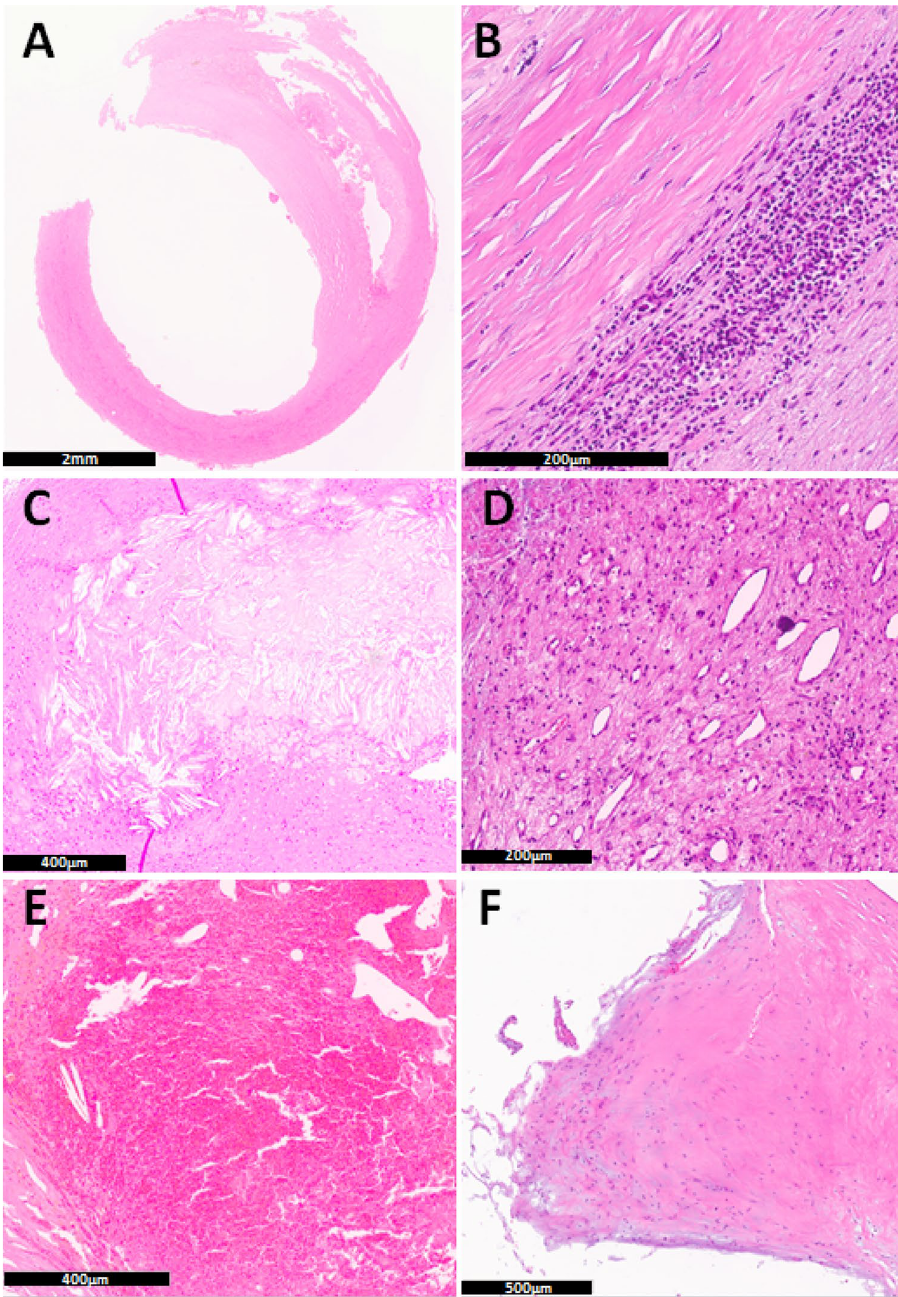
Figure 1. Histological criteria of plaque vulnerability. Representative sections displaying criteria of the histological sum score. Carotid plaque, HE-staining (overview, scale bar: 2 mm) ( A ). Representative areas of different specimens showing chronic inflammation (scale bar: 200 µm) ( B ), cholesterol crystals (scale bar: 400 µm) ( C ), neovascularization (scale bar: 200 µm) ( D ) intraplaque hemorrhage (scale bar: 400 µm) ( E ) and an adherent thrombus (scale bar: 500 µm) ( F